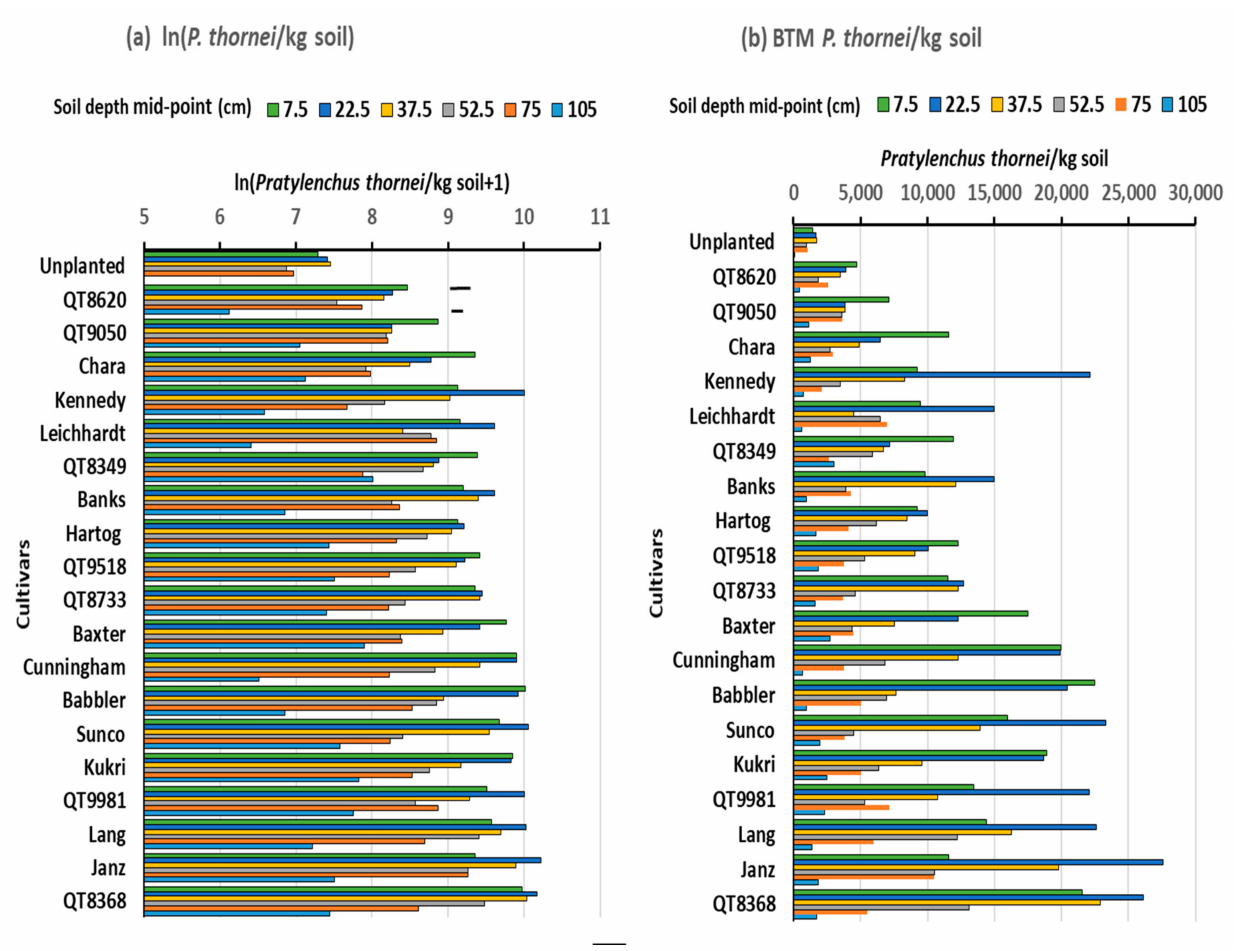
Figure 3. Population densities of Pratylenchus thornei in the soil profile in depth intervals of 0–15, 15–30, 30–45, 45–60, 60–90 and 90–120 cm after harvest of 19 wheat cultivars in Experiment 2, ( a ) mean values for ln( P. thornei /kg soil+1) from ANOVA with bar markers ( p = 0.05) for main effects of cultivar and soil depth, ( b ) back-transformed values of number of P. thornei /kg soil. Cultivars are in ascending order of mean P. thornei population